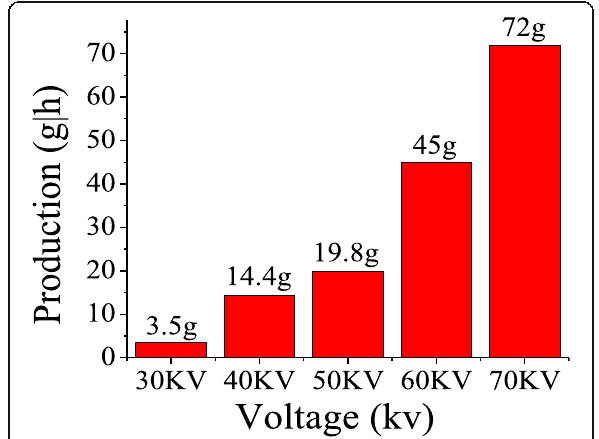
Fig. 6 The production with the different applied voltage using MFSE